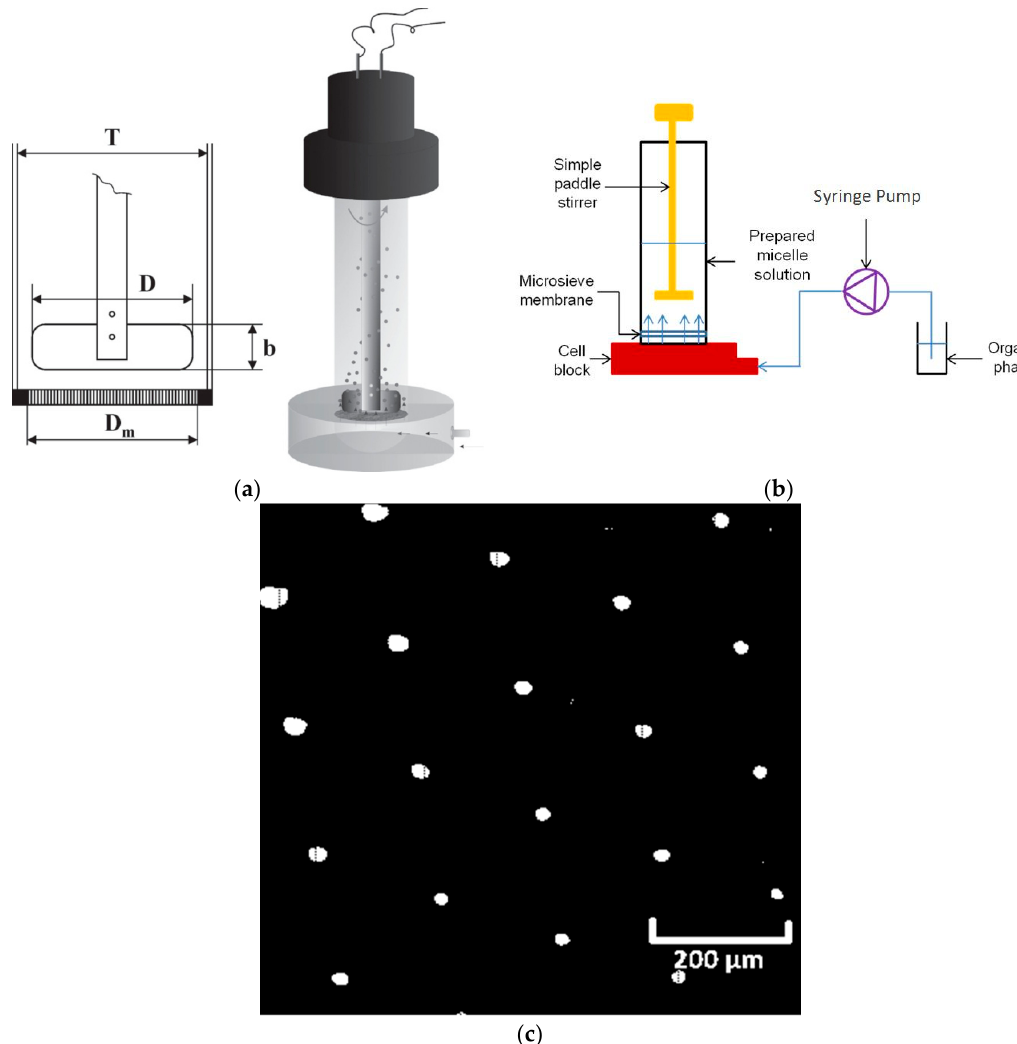
Figure 2. ( a ) Schematic diagram of stirred cell with paddle stirrer above a flat disc membrane; Diameter of stirring blade, D = 32 mm, width of stirring blade, b = 12 mm, diameter of stirred cell, T = 40 mm, and effective diameter of membrane, D m = 33 mm. ( b ) Schematic diagram of the experimental set-up for membrane device. ( c ) A micrograph of the membrane surface showing cylindrical pores with constant pore to pore spacing.